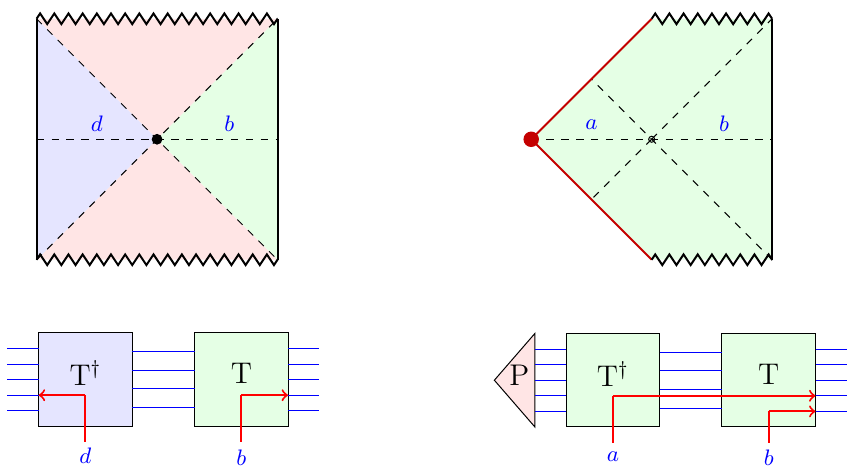
Figure 12 . Tensor network representation of the one-sided reconstruction of interior and exterior operators for the thermo-(cid:12)eld double state (left) and the thermal pure state (right). The recon- struction map of the bulk operators is indicated by the corresponding red arrows. Figure taken from [14,